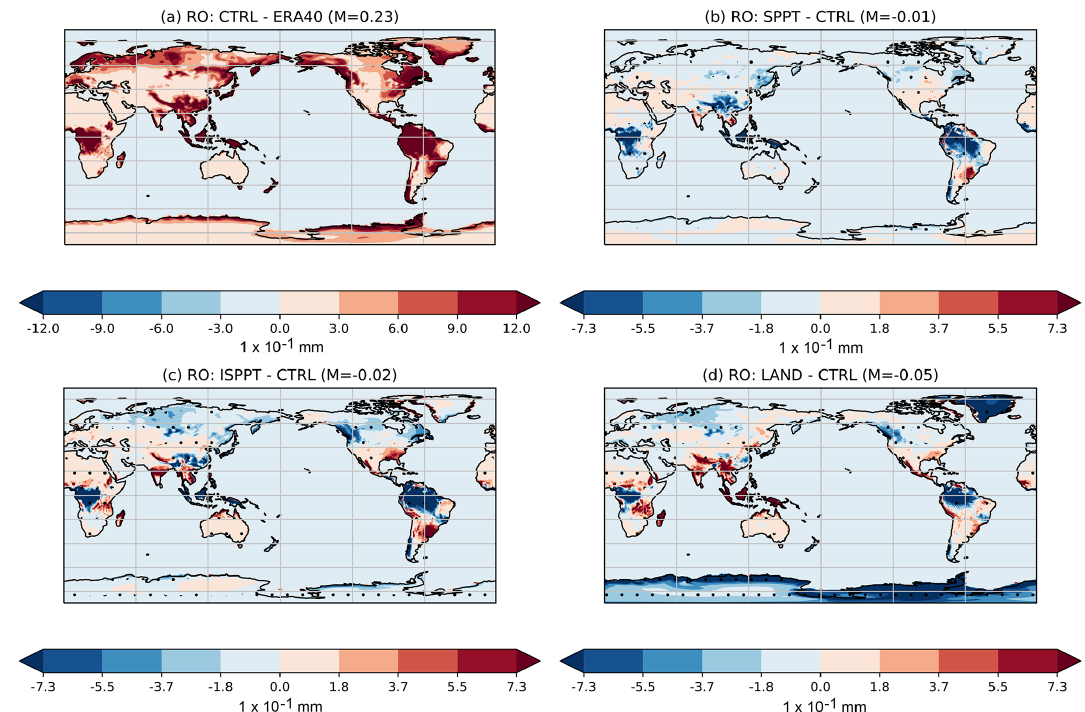
Figure 8. Mean differences in runoff between the (a) CTRL and ERA40, (b) SPPT and CTRL, (c) ISPPT and CTRL, and (d) LAND and CTRL. Stippling indicates regions where the difference is statistically significant to the 95% confidence interval, as measured by a two-tailed t test. In each panel, M denotes the mean of the difference. Note the difference in the scales between (a) and (b, c, d) .